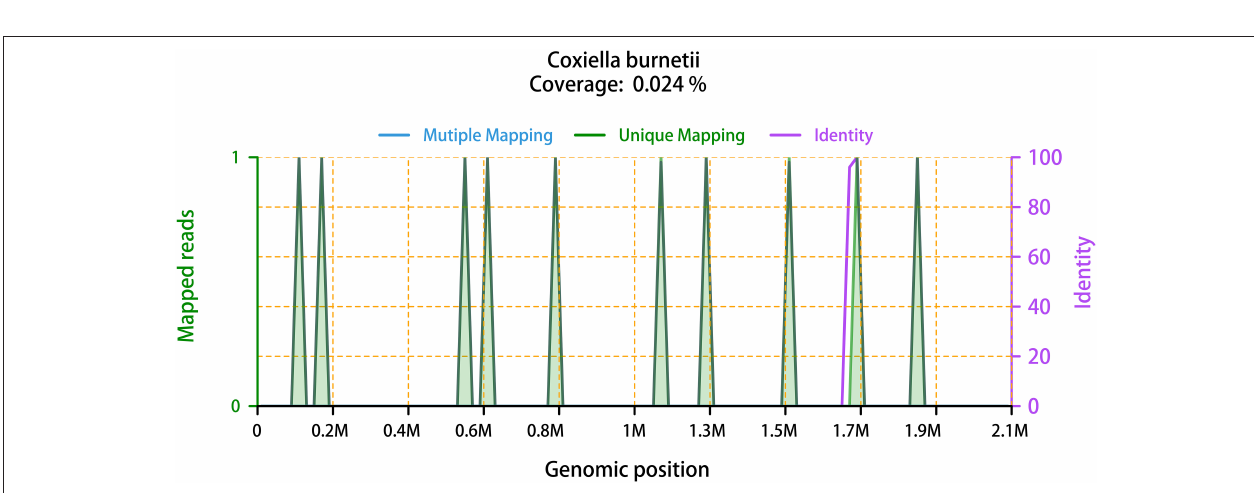
FIGURE 1 | Clinical course of the 48-year-old patient. Timeline showed the dynamic monitoring of the patient’s body temperature, and the level of CRP, ALT, AST, GGT. Besides, daily treatment schemes of the patient were recorded. CRP, C-reactive protein; ALT, alanine transaminase; AST, aspartate aminotransferase; GGT, gamma-glutamyltransferase; LEV, levofloxacin; TZP, piperacillin-tazobactam; ACV, acyclovir; DOX, doxycycline; DXM, dexamethasone; ivgtt, intravenously guttae.